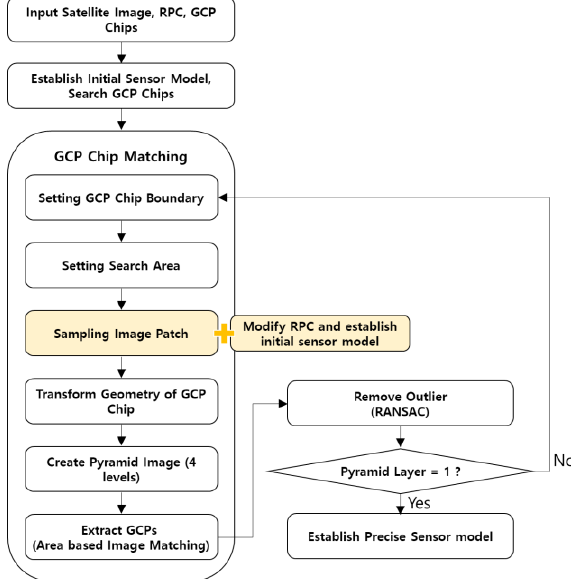
Figure 4. Flow of GCP Chip matching